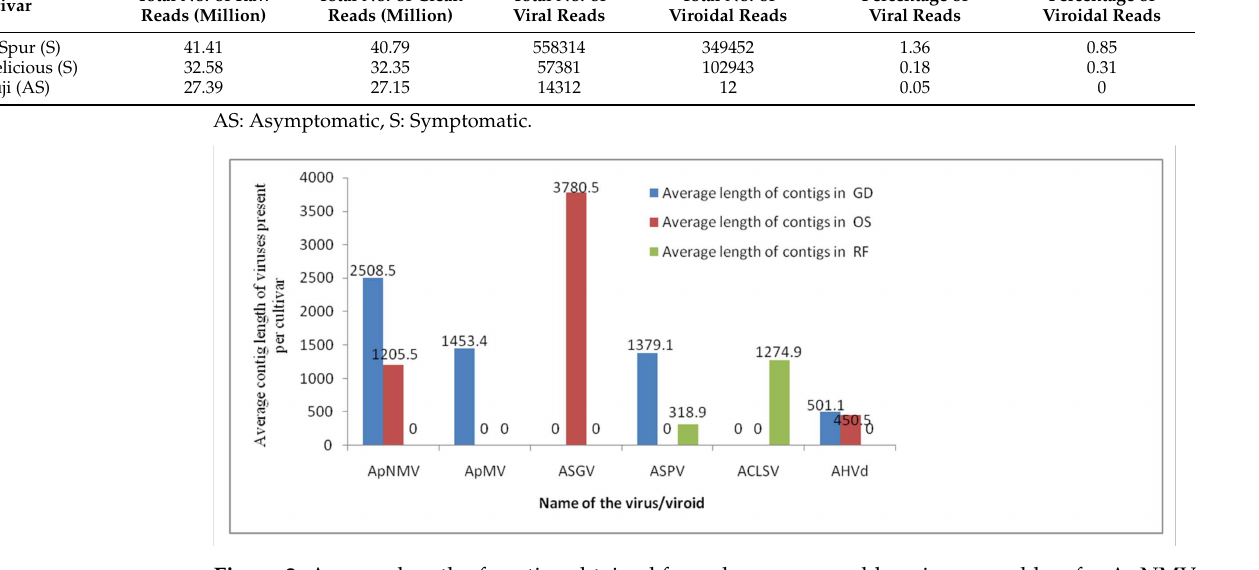
Figure 2. Average length of contigs obtained from de novo assembly using assemblers for ApNMV, ApMV, ASGV, ASPV, ACLSV and AHVd present per